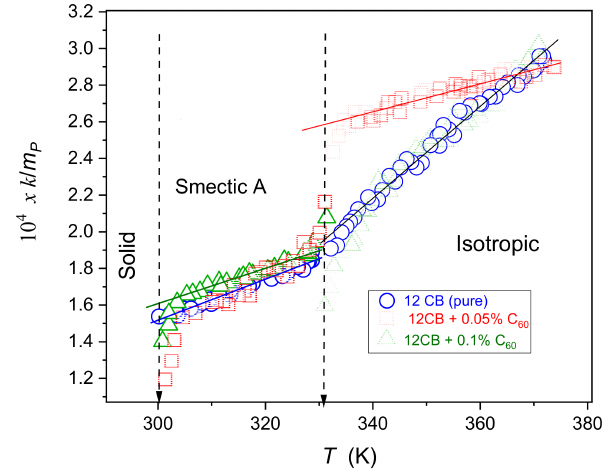
Figure 7. Temperature evolutions of the apparent fragility in the 12CB and its nanocolloids with C 60